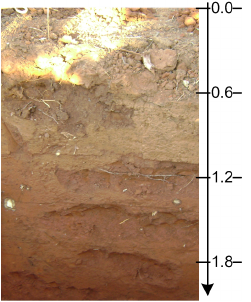
Figure 23. Profile of Nitisol. Table 9. Pedogenetic horizons of the